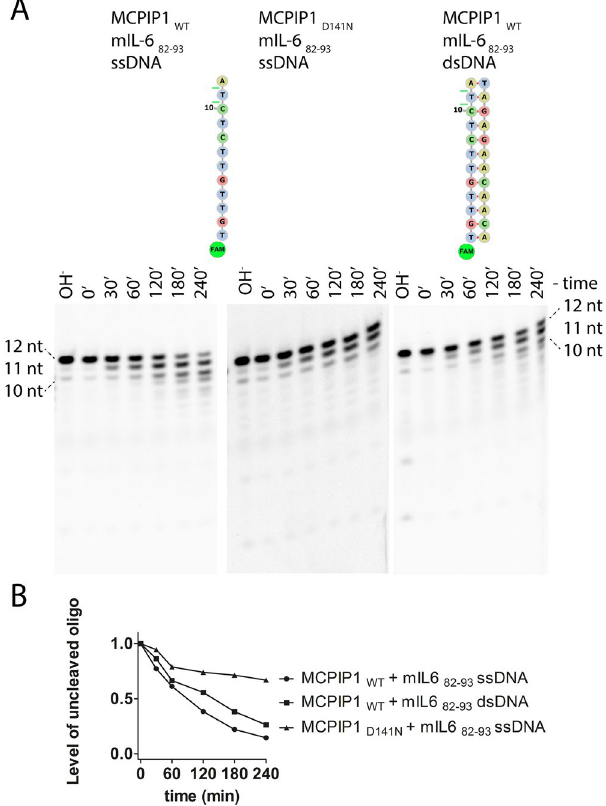
Figure 3. DNA fragments obtained upon cleavage catalyzed by MCPIP1. ( A ) The DNA sequences are based on the mIL-6 82–106 sequence; one oligonucleotide is ssDNA, and the second is dsDNA. The oligonucleotides were labeled at the 5 ′ end with FAM dye. The reaction products were resolved on 20% denaturing PAGE and visualized with a fluorescence imaging system. Concentrations of the labeled oligonucleotides and MCPIP1 protein were 7.5 μ M and 2 μ M, respectively. The D141N mutation of a conserved aspartate of the PIN domain catalytic center of the MCPIP1 decreased its ribonucleolytic activity. ( A ) Was made by the separation of gels that are shown at Supplementary Fig. S2C,D. ( B ) Densitometric analysis of the level of the remaining uncleaved ssDNA and dsDNA oligonucleotides from the MCPIP1 nuclease activity assay at different time